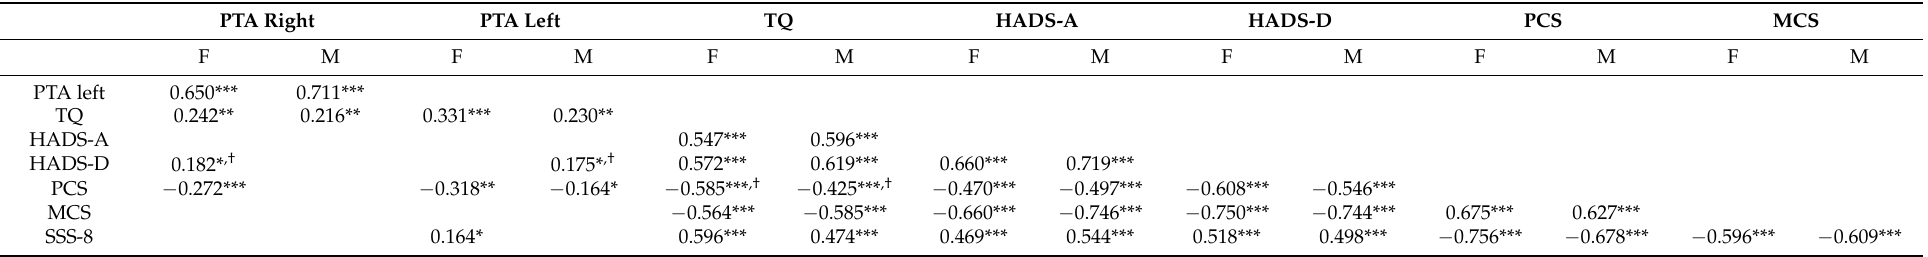
Table 3. Significant Pearson correlation coefficients r for the obtained measures. All coefficients are comparable between genders except where otherwise indicated. PTA Right PTA Left TQ HADS-A HADS-D PCS MCS F M F M F M F M F M F M F M PTA left 0.650*** 0.711*** TQ 0.242** 0.216** 0.331*** 0.230** HADS-A 0.547*** 0.596*** HADS-D 0.182* ,† 0.175* ,† − 0.272*** − 0.318** − 0.164* − 0.585*** ,† − 0.425*** ,† − 0.470*** − 0.497*** − 0.608*** − 0.546*** MCS − 0.564*** − 0.585*** − 0.660*** − 0.746*** − 0.750*** − 0.744*** 0.675*** 0.627*** SSS-8 0.164* 0.596*** 0.474***